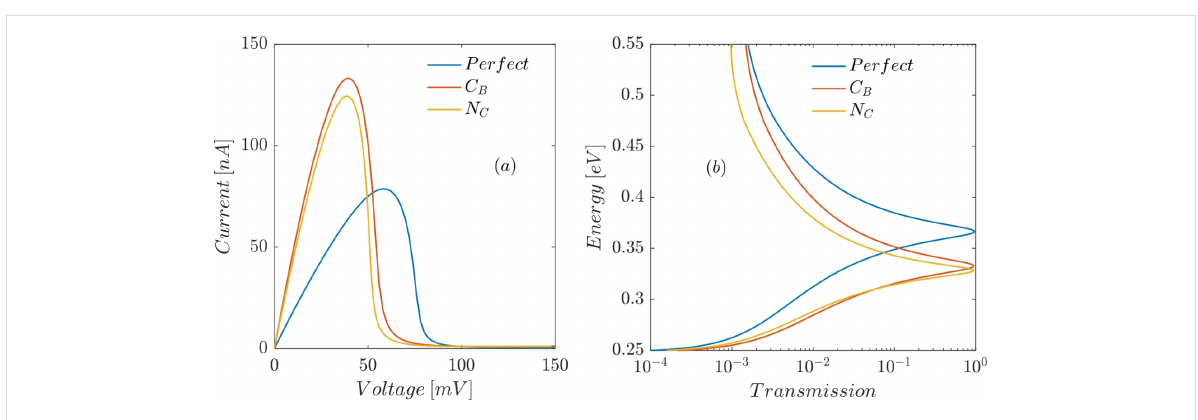
Figure 4: Effect of C B and N C defects at the interface between the left ABNNR barrier and the well on (a) the current–voltage characteristic and (b) the transmission trough the proposed RTD as a function of the electron energy.